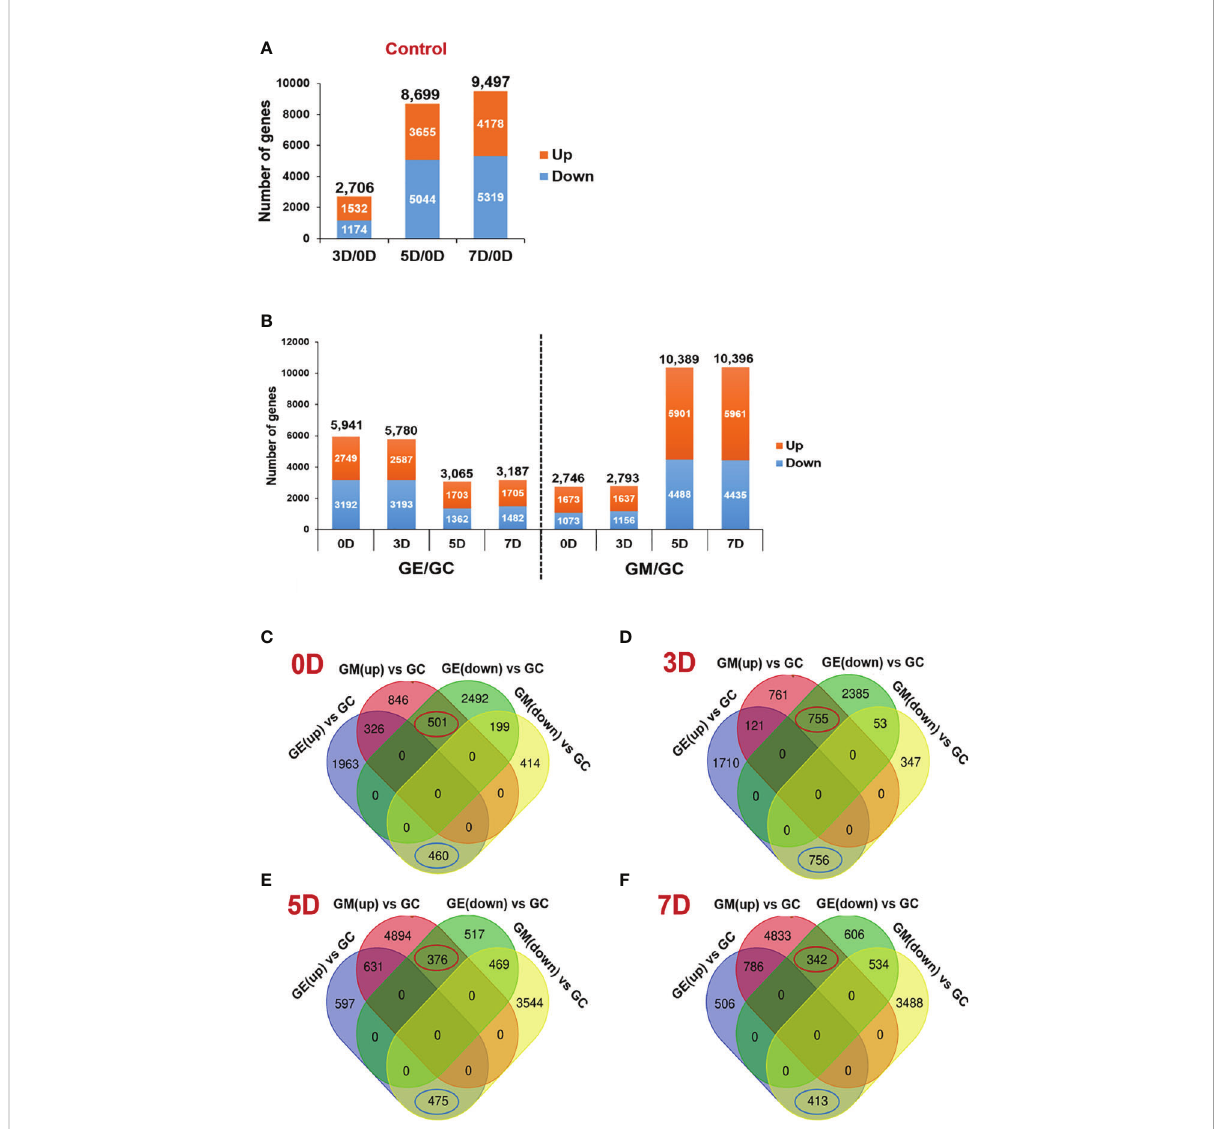
FIGURE 2 Identi fi cation of DEGs between ET-treated and control samples or between 1-MCP-treated samples and control samples. (A) Number of DEGs along the ripening time course of kiwifruit at 3, 5, and 7 days (3D, 5D, and 7D), respectively, compared to 0 days (0D) control. (B) Number of DEGs along the ripening course of kiwifruit at 0D, 3D, 5D, and 7D between ET-treated (GE) and control samples (GC) or 1-MCP-treated (GM) and control samples, respectively. (C) Venn diagram showing the overlapping and uniquely DEGs at 0D, compared between ET-treated sample and 1-MCP-treated sample. A total of 501 genes were upregulated by 1-MCP and downregulated by ET, whereas 460 genes were downregulated by 1-MCP and upregulated by ET. (D) Venn diagram showing the overlapping and uniquely DEGs at 3D, compared between ET- treated sample and 1-MCP-treated sample. A total of 755 genes were upregulated by 1-MCP and downregulated by ET, whereas 756 genes were downregulated by 1-MCP and upregulated by ET. (E) Venn diagram showing the overlapping and unique DEGs at 5D, compared between ET-treated sample and 1-MCP-treated sample. A total of 376 genes were upregulated by 1-MCP and downregulated by ET, whereas 475 genes were downregulated by 1-MCP and upregulated by ET. (F) Venn diagram showing the overlapping and uniquely DEGs at 7D, compared between ET-treated sample and 1-MCP-treated sample. A total of 342 genes were upregulated by 1-MCP and downregulated by ET, whereas 413 genes were downregulated by 1-MCP and upregulated by ET. DEG, differentially expressed gene; ET, ethylene; 1-MCP, 1-methylcyclopropene; GM, green kiwifruit with 1-MCP treatment; GC, green kiwifruit with no treatment (control); GE, green kiwifruit with ET